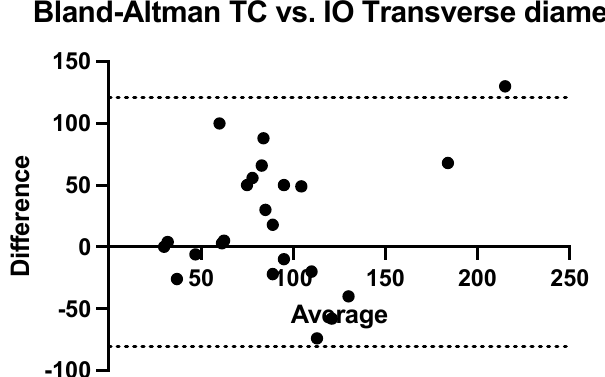
Figure 7. Bland-Altman analysis comparing transverse diameter measured using ultrasound versus intraoperative measurement (US = ultrasound, IO = intraoperatively).